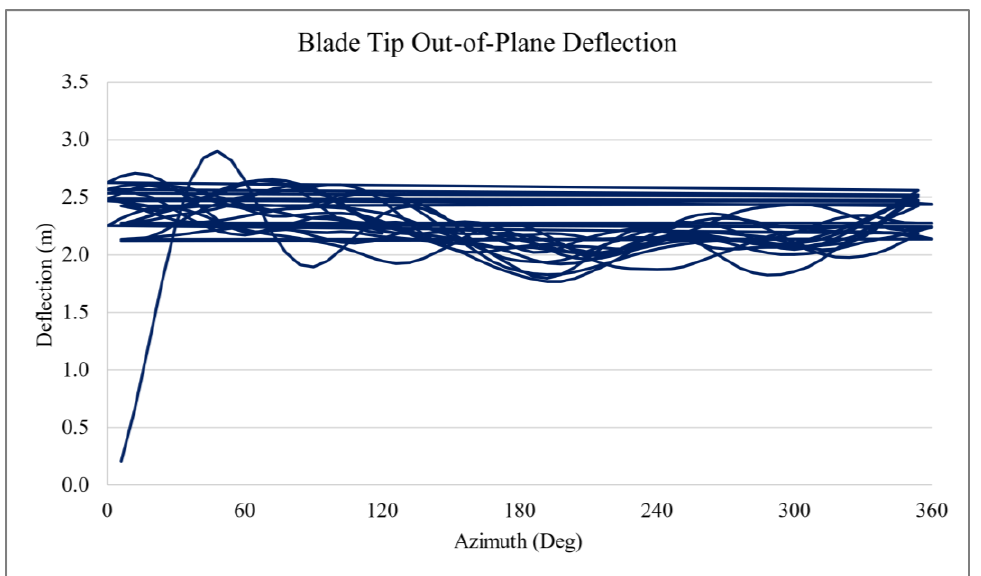
Figure 9. Blade Tip Out-of-Plane Deflection with Azimuth Angle - 10% Turbulence